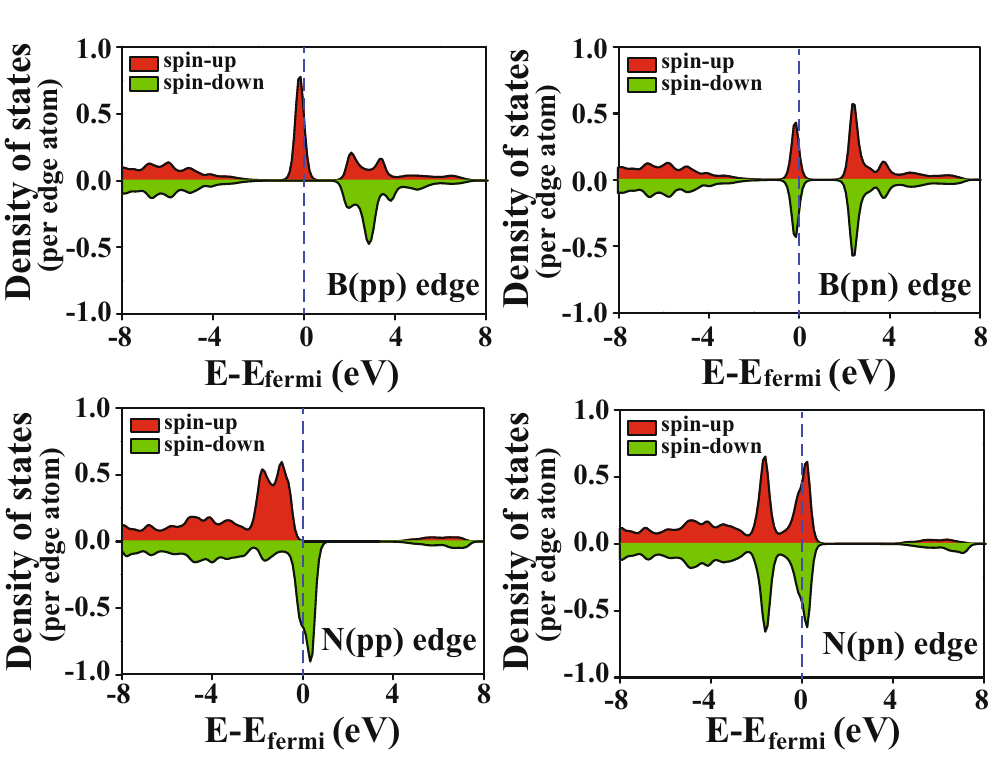
Figure 5. Spin polarized PDOS of individual edges of